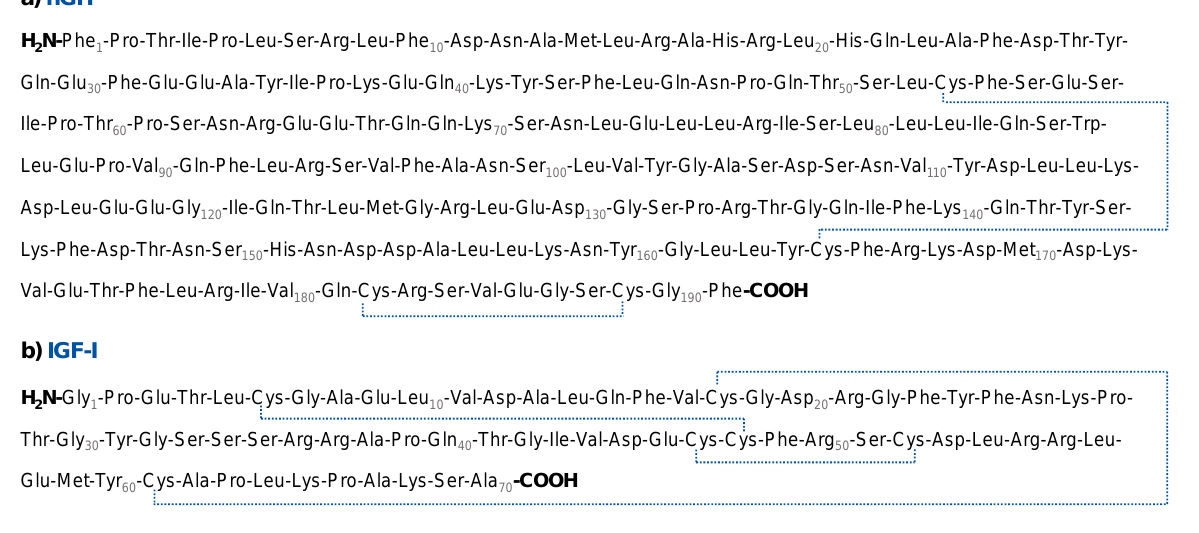
Figure 1. Primary structures of the two peptides examined within this study: ( a ) human growth hormone and ( b ) insulin-like growth factor-I.